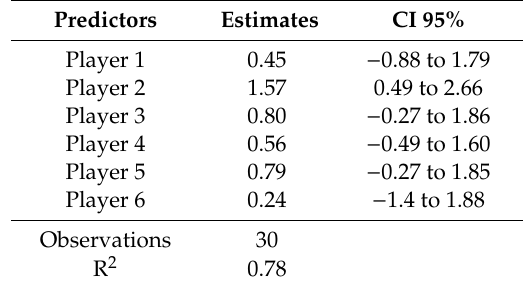
Table 2. Confidence intervals (CI) for individual testosterone changes depending on ELO di ff erences between rivals.